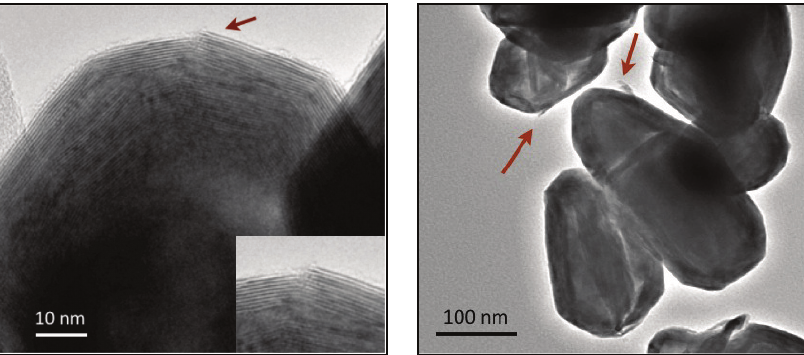
Figure 4. Left : TEM micrograph of a particle treated with ultrasonic horn that presents a surface crack. The inset is a magnified version of the area pointed by the arrow; Right : TEM studies corroborated the damage of both, internal and external layers of the IF